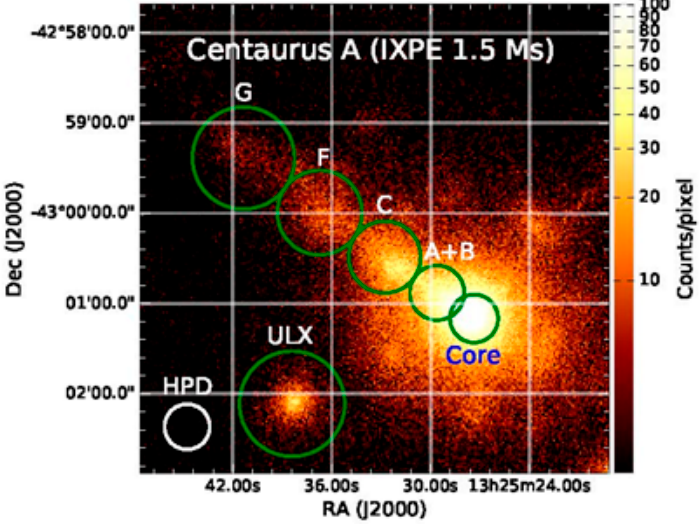
Figure 17. ( Left ) Looking down on the galactic center. The red asterisk is Sagittarius A* and the blue object to the left is a representation of the molecular cloud SgR B2. X-rays emitted by SgR A* may be scattered to IXPE by SgR B2; ( right ) View of the galactic center from IXPE. The square in the top right of the figure represents the size of the IXPE field of view and the HPD is the half-power-diameter showing that SgR B2 is clearly resolved. The dashed line pointing back to SgR A* represents the position angle of the scattered X-rays and the solid lines represent the measured uncertainty. Galaxies 2018 , 6 , x FOR PEER REVIEW